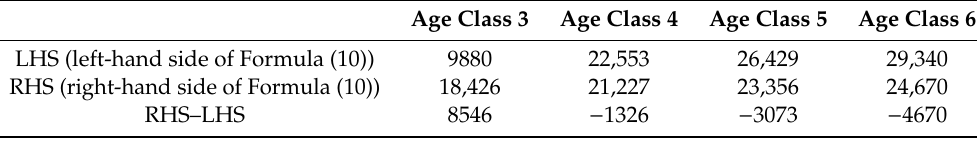
Table 5. Profits generated from harvesting by age class: forested area.